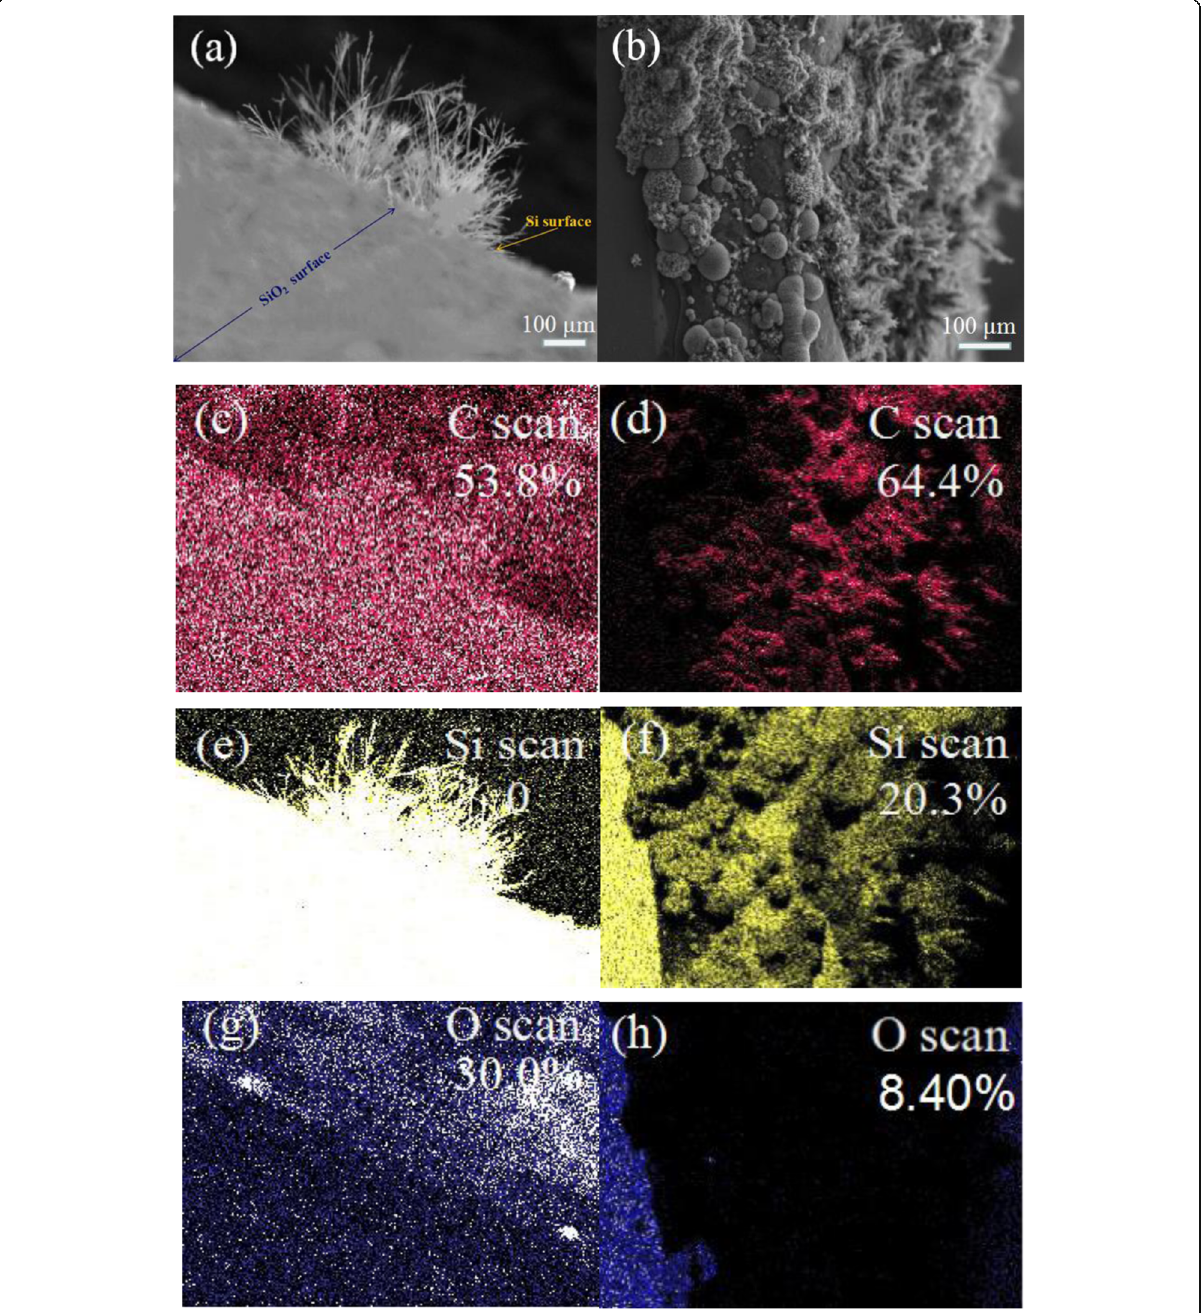
Fig. 4 SEM images of graphene dendrites grown on the Si surface ( a ) and SiO 2 surface ( b ). EDS maps of element content of C ( c ), Si ( e ), and O ( g ) scanned in the same area with ( a ). EDS maps of element content of C ( d ), Si ( f ), and O ( h ) scanned in the same area with ( b